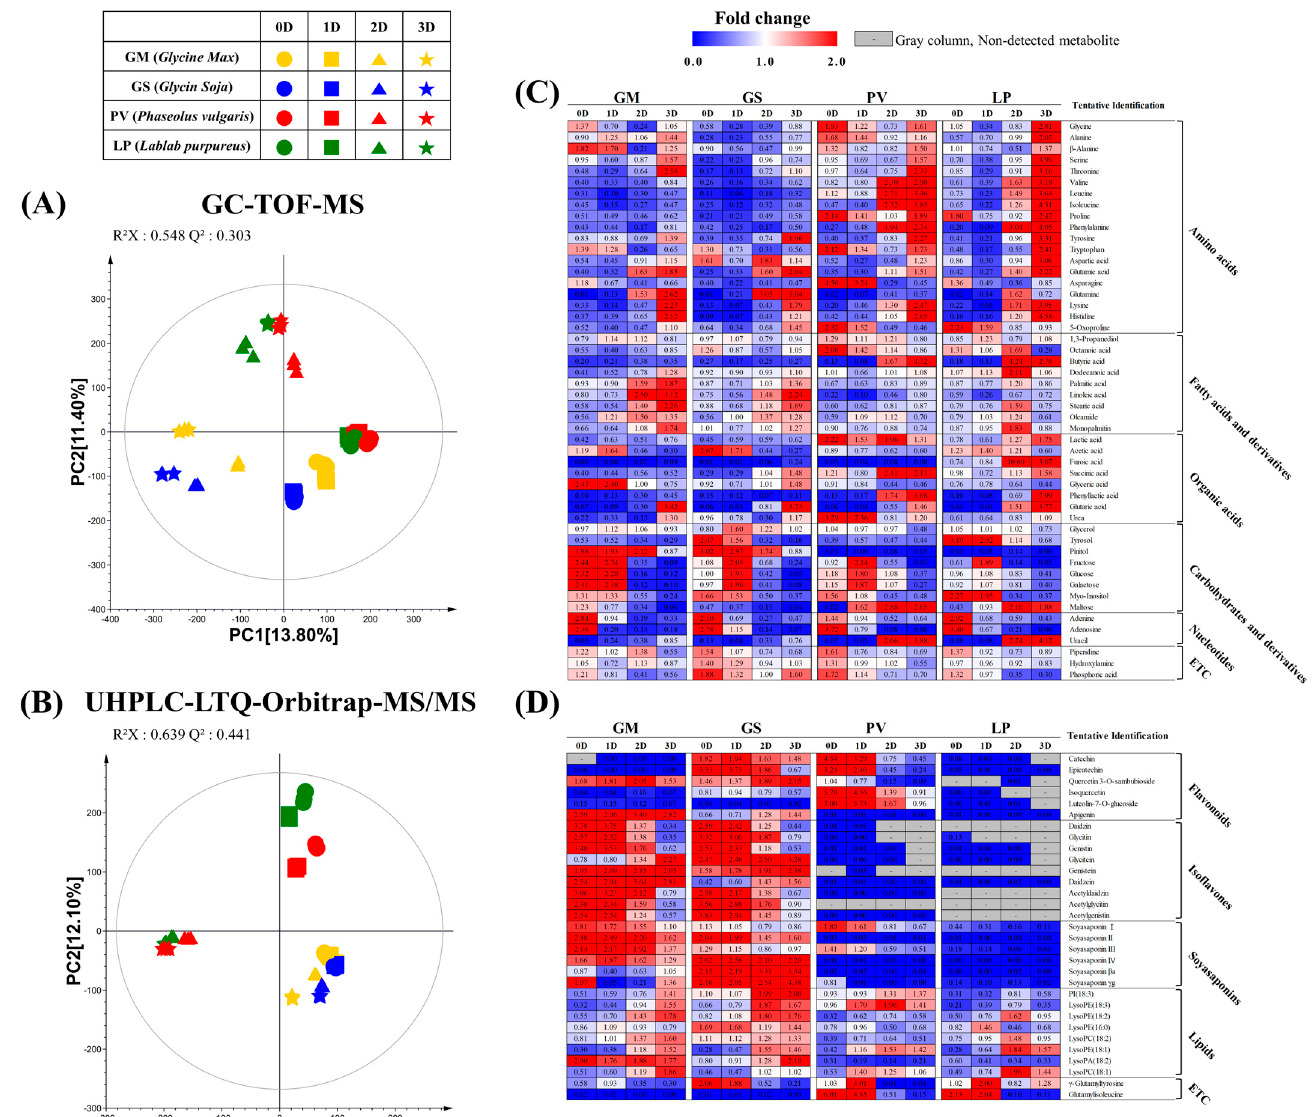
Figure 3. PCA analyses and heatmap analyses of the metabolites in the four beans that were fermented with A. oryzae . The methods included GC-TOF-MS ( A , C ) and UHPLC-LTQ-Orbitrap-MS/MS ( B , D ). The heatmap represents the relative content of significantly different metabolites determined by the partial least squares discriminant analysis (PLS-DA) model (VIP > 0.7, p -value < 0.05). The colored blocks represent the fold changes (blue to red) normalized by the average of all values for each metabolite. The colors indicate the relative abundances of each metabolite. Blue color: lower content relative to the mean, red color: higher content relative to the mean. GM: G. max , GS: G. soja ,